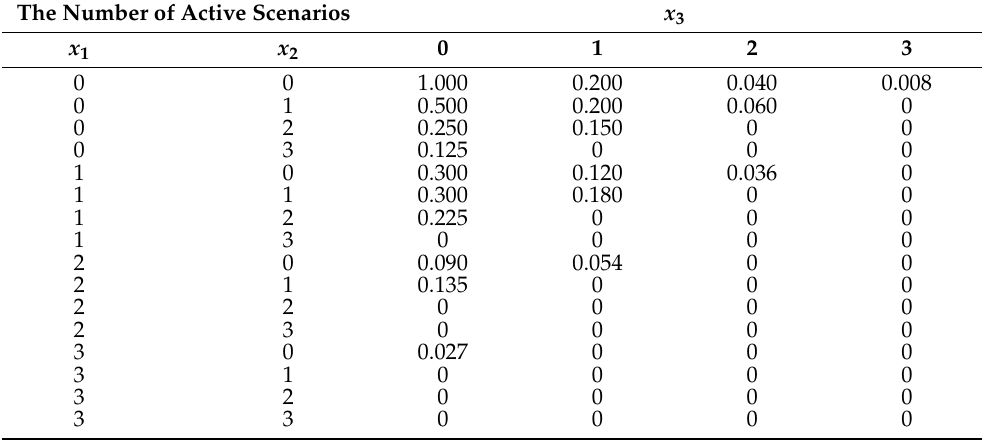
Table 3. The combination probabilities p ( x 1 , x 2 , x 3 ) of the scenarios in the railcar system under the assumption x n ≤